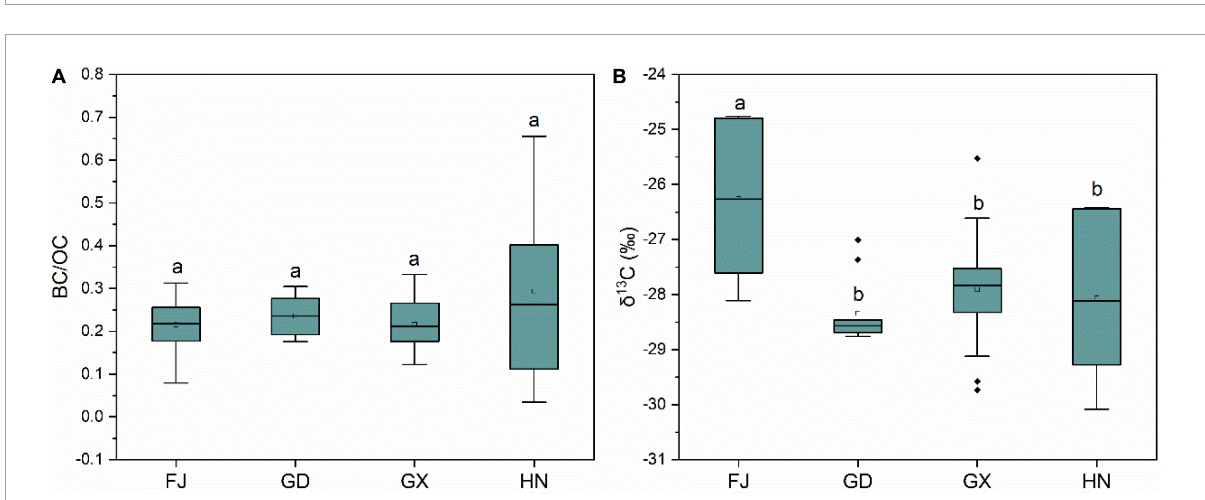
FIGURE6 Boxplots showing the ratio of black carbon (BC) to the organic carbon (OC) (A) and δ 13 C content (B) in the sediments from different mangrove wetlands in China. Different lowercase letters indicate significant differences ( α = 0.05). FJ, Fujian; GD, Guangdong; GX, Guangxi; HN,